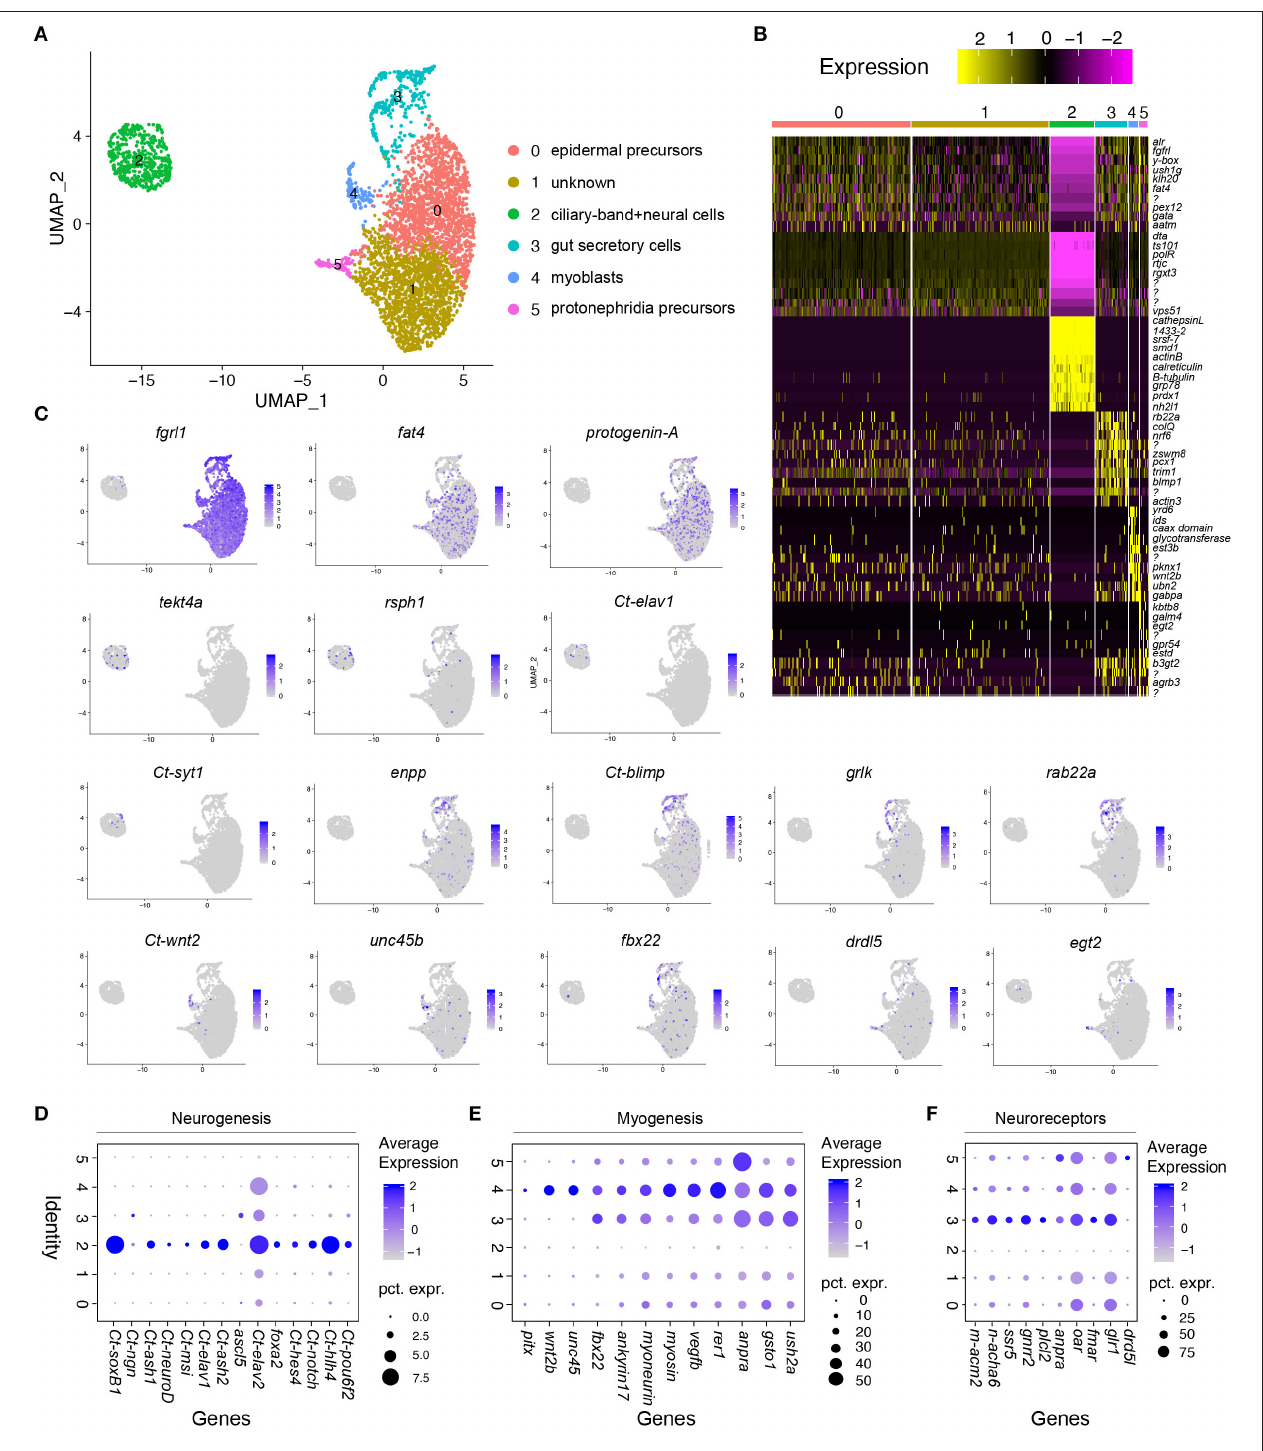
FIGURE 2 | Mapping of C. teleta larval tissues from aggregated stage 4 and 5 datasets. (A) UMAP representation of the aggregated data (stages 4 and 5), where the clustering of cells depicts their transcriptional similarity. (B) Heatmap of the top 10 genes significantly enriched in each cluster. Representative gene names obtained from closest reciprocal BLAST hits are shown close to each row. The full gene-list is in Supplementary Table 2 . (C) UMAP plots showing log-normalized counts of select representative genes from each cluster. Color intensity is proportional to the expression level (purple: high; gray: low). (D) Dotplot of representative genes involved in C. teleta neurogenesis. (E) Dotplot showing novel markers implicated in C. teleta myogenesis. (F) Dotplot showing orthologs of neurotransmitter and neuropeptide/neurohormone receptors across clusters.